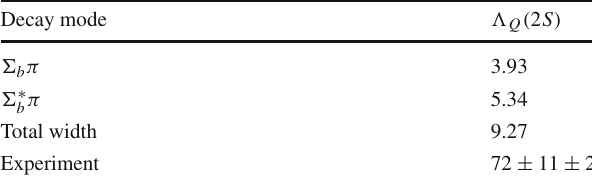
Table 2 Strong decays of the (cid:2) b ( 6072 ) as (cid:2) b ( 2 S ) state in MeV